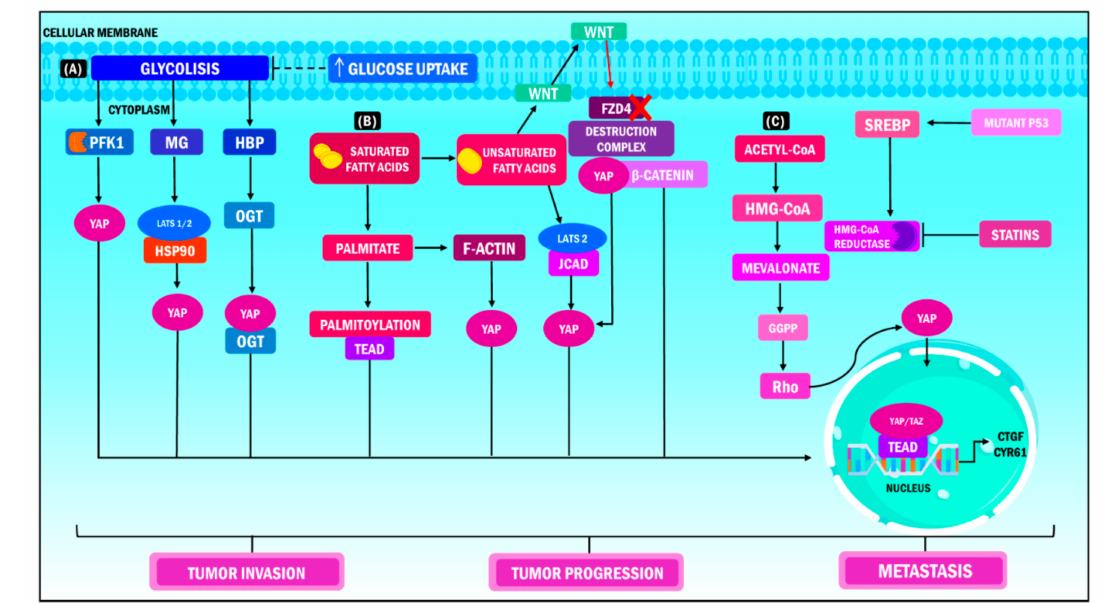
Figure 3. YAP/TAZ functions in metabolic heterogeneity. YAP/TAZ operate as nuclear and transcrip- tional mediators in different metabolic pathways during cancer, which results in increased tumor invasion, tumor progression and metastasis. ( A ) When YAP/TAZ activity is stimulated, the cell increases its glucose demand to promote glycolysis; the PFK1 enzyme is the coordinator of this inter- action, considering that it regulates the stability of the union of the YAP/TAZ/TEAD complex in the cellular nucleus. ( B ) In terms of lipid metabolism, the release of free fatty acids induces the expression of the JCAD protein, while transcription of YAP occurs simultaneously through its dephosphorylation and union to the LATS2 domain. Consequently, translocation of YAP at the nuclear level, activation of the transcriptional module and transcription of target genes ensue. ( C ) The metabolism of mevalonate regulates the activity of YAP/TAZ through the production of geranyl pyrophosphate, which activates the Rho GTPase, which in turn dephosphorylates YAP/TAZ, promoting its accumulation in the cell nucleus and the transcription of its target genes. On the other hand, high levels of mevalonic acid boost the oncogenic activity of YAP /TAZ through the transcription of SREBP induced by the mutation of its cofactor p53. YAP: Yes-associated protein; TAZ: Transcriptional coactivator